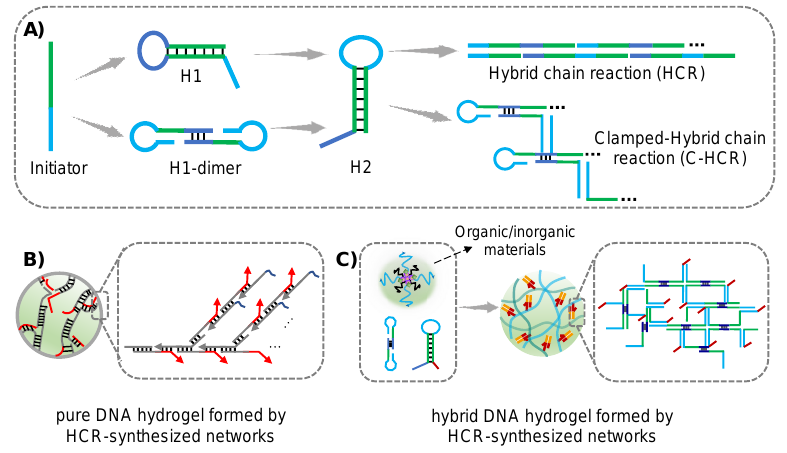
Figure 3. ( A ) The schematic of HCR principle. ( B ) Pure DNA hydrogel formed by HCR-synthesized networks. ( C ) Hybrid DNA hydrogel formed by HCR-synthesized networks.